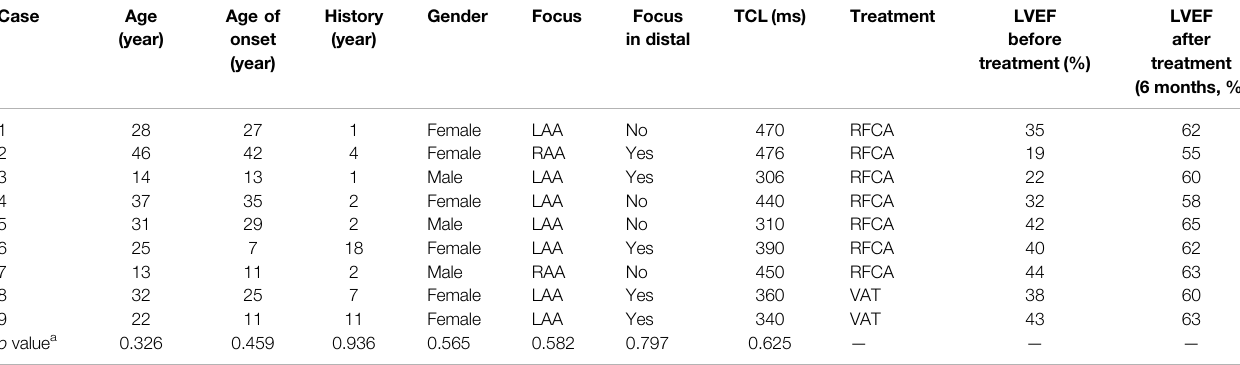
TABLE 2 | Clinical and electrophysiological characteristics in patients with